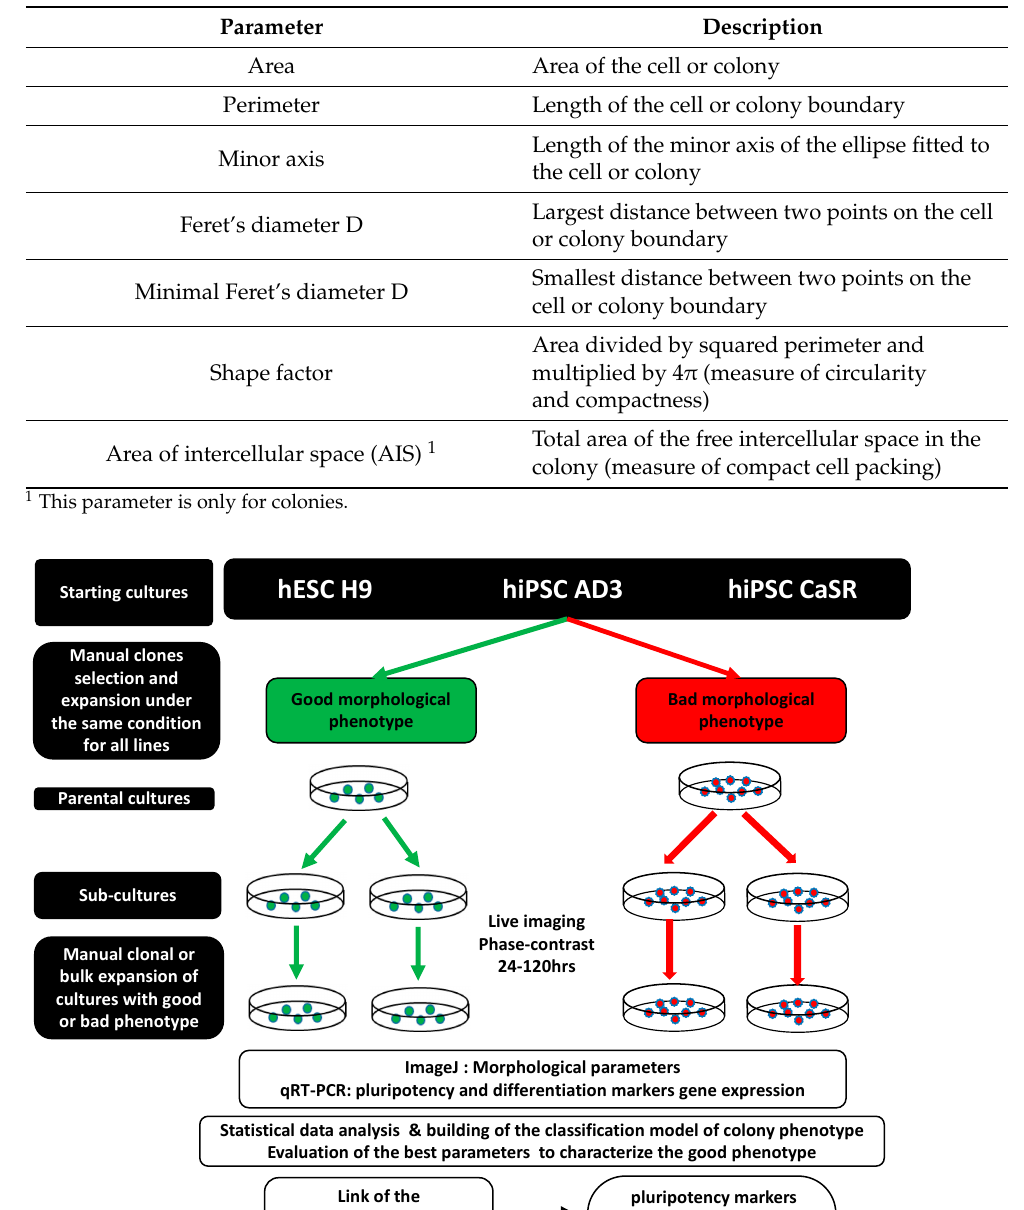
Table 1. Morphological parameters extracted from the images of cells and colonies.